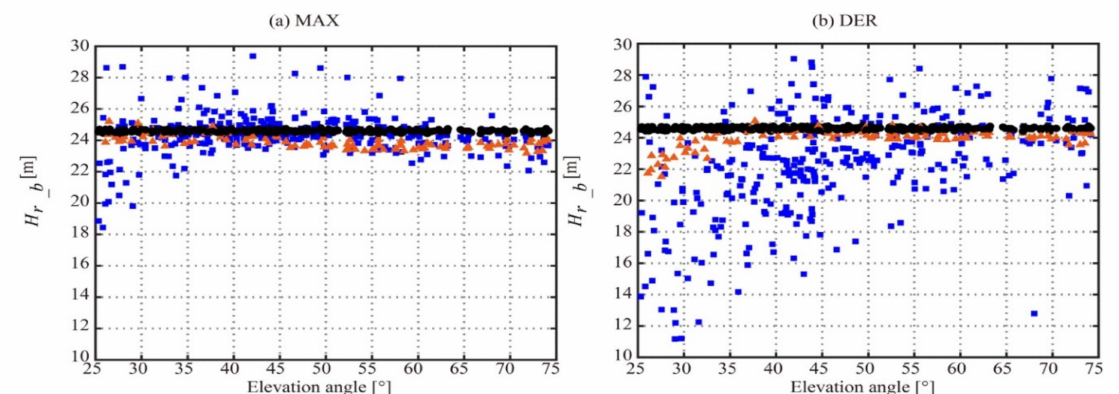
Figure 8. Scatter plot of the ocean altimetry results obtained after correction of the elevation angle influence using the model-driven function, according to Equation (7). ( a , b ) are the height of the coastal receiver relative to the sea surface obtained using different signals and types of characteristic